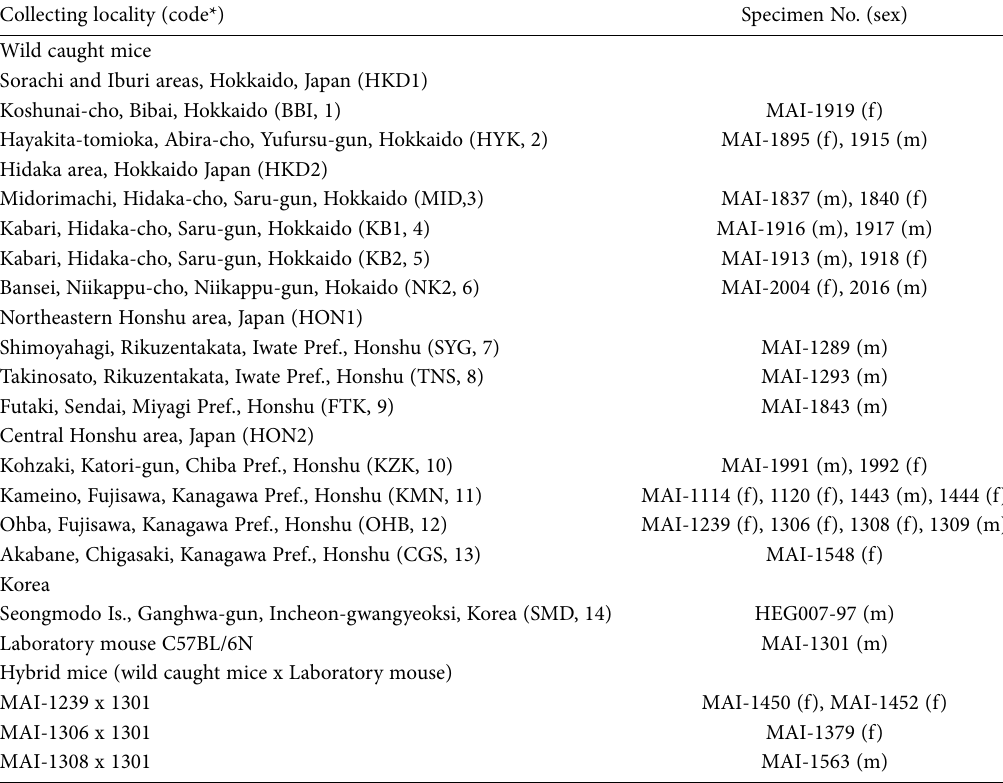
Table 1. House mouse samples examined in this study.